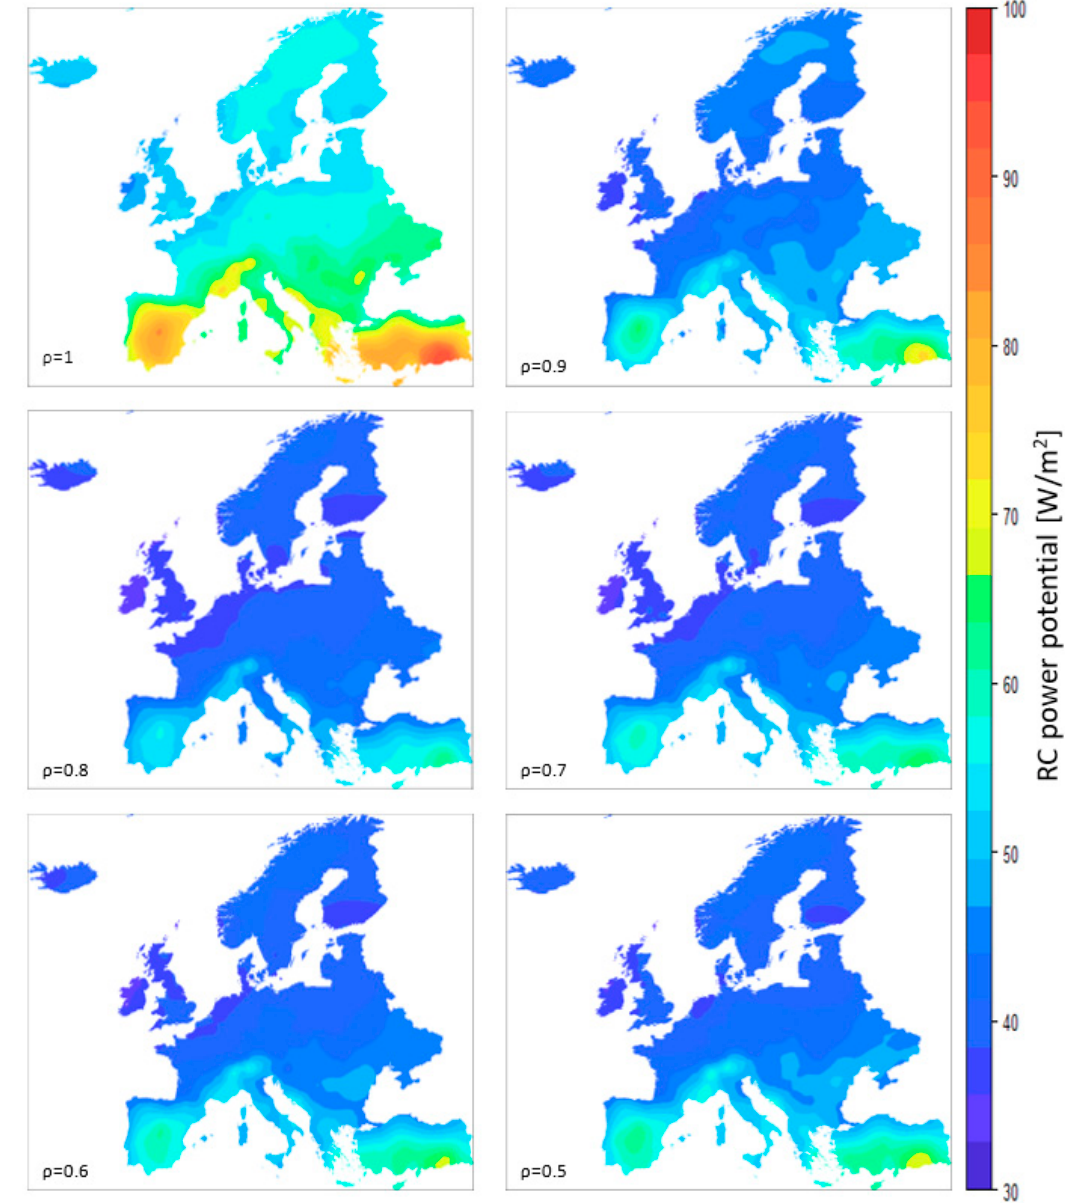
Figure 4. Map of RC power potential (W/m 2 ) for six values of solar radiation reflectivity.